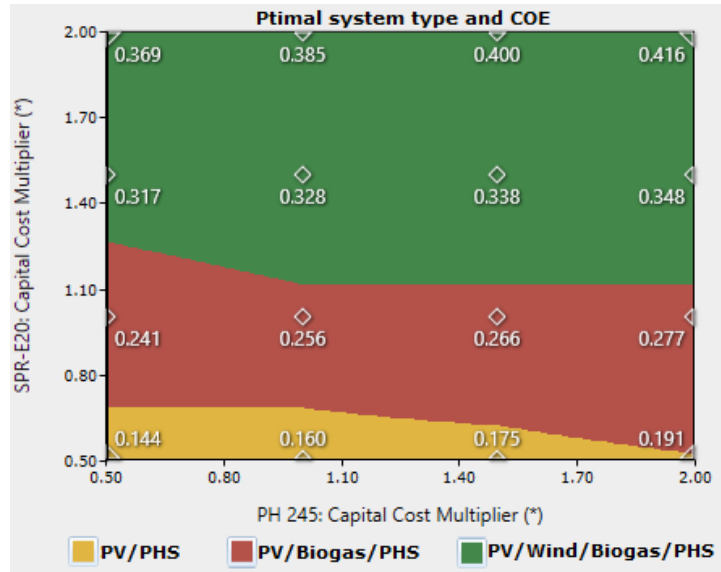
Figure 19. Sensitivity analysis result of PV and PHS capital costs.